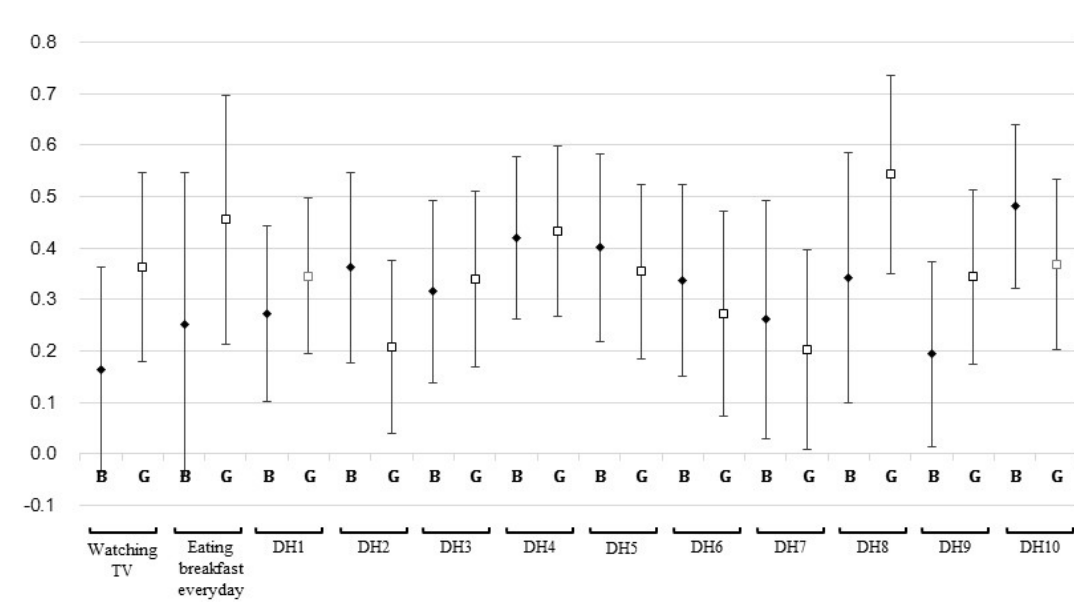
Figure 1. Weighted κ of two repeated measures for behaviors by sex. B: boys (black diamonds), G: girls (white squares), line indicates 95% confidence interval. DH1: Eating more than two portions of milk or dairy products every day. DH2: Eating meat, fish, egg, beans, or tofu with every meal. DH3: Eating vegetables other than kimchi with every meal. DH4: Eating one portion of fruit or drinking